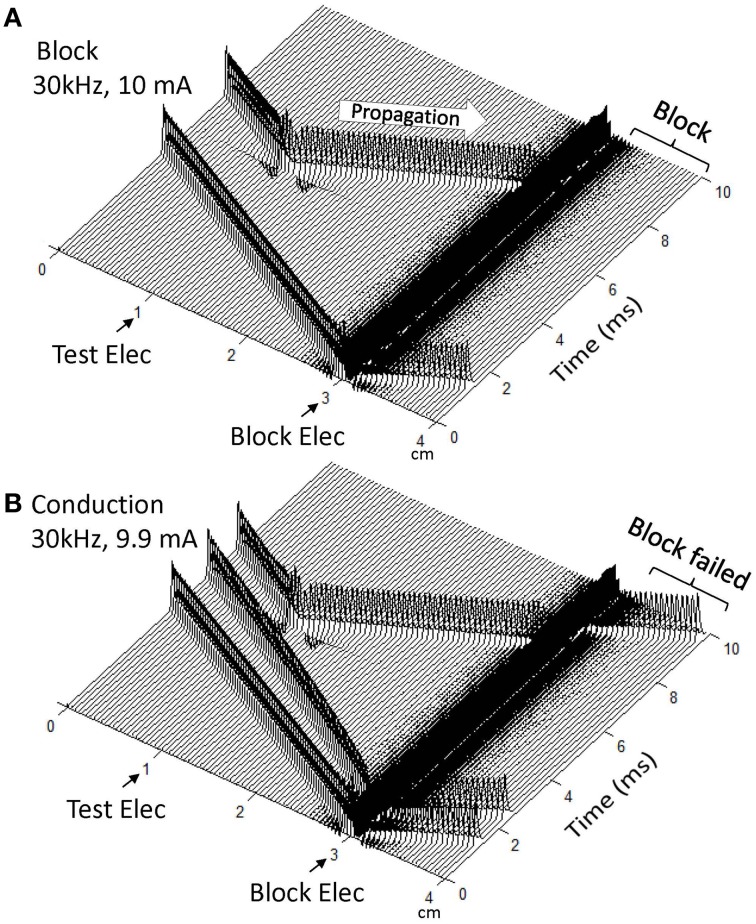
Blocking the propagation of action potentials along a myelinated axon by high-frequency symmetric biphasic stimulation. High-frequency (30 kHz) stimulation is continuously delivered at the block electrode, which initiated an initial action potential in (A) and two initial action potentials in (B). Another action potential is initiated via the test electrode at 5 ms after starting the high-frequency stimulation, and propagates toward both ends of the axon. The 30 kHz stimulation blocks nerve conduction at the intensity of 10 mA (A), but not at 9.9 mA (B). Both symmetric and non-symmetric waveforms induced initial action potentials and axonal conduction block, which are dependent on stimulation frequency and intensity as shown previously [33]. The short arrows mark the locations of test and block electrodes along the axon. The white arrow indicates propagation of the action potential to the location of the 30 kHz blocking stimulation. Axon diameter: 2 μm.